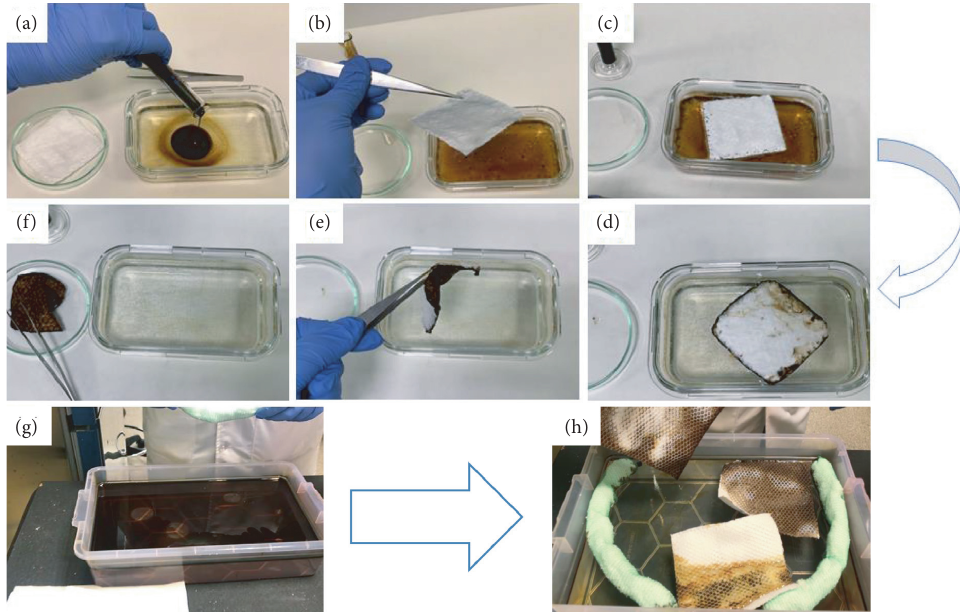
Figure 6: Demonstration of oil spill removal using a typical sheet containing PS fibrous